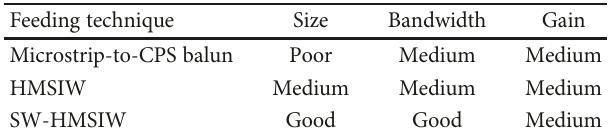
Table 3: The comparison of antenna performance for di ff erent feeding